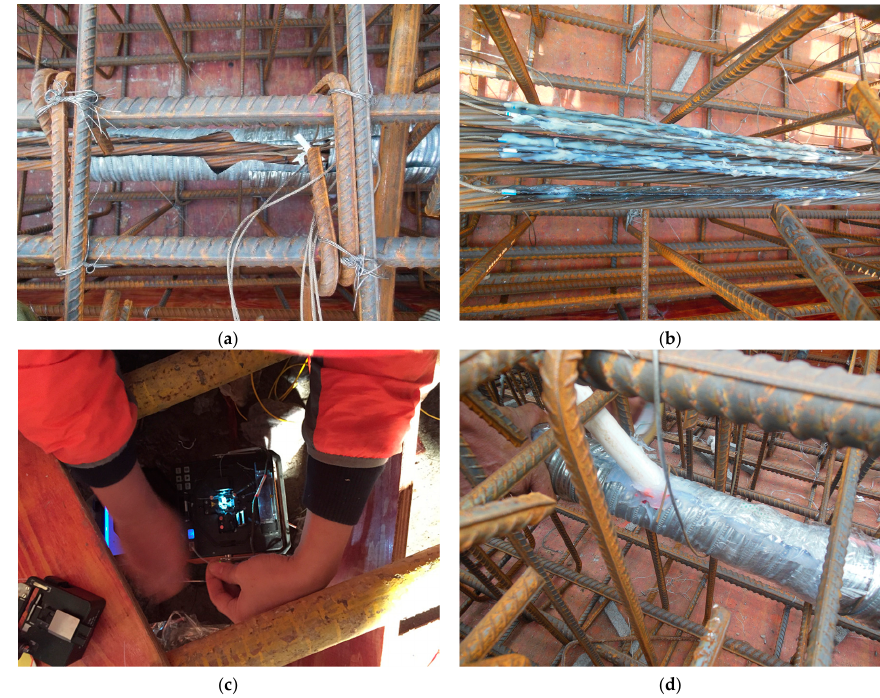
Figure 11. Photographs of the LFBG sensor deployment in in-site monitoring: ( a ) Peeling the marked region to expose the tendon; ( b ) attaching the LFBG sensors on the strands; ( c ) connecting the sensor to the optical cable; and ( d ) connecting the protection sleeve to the pipe.